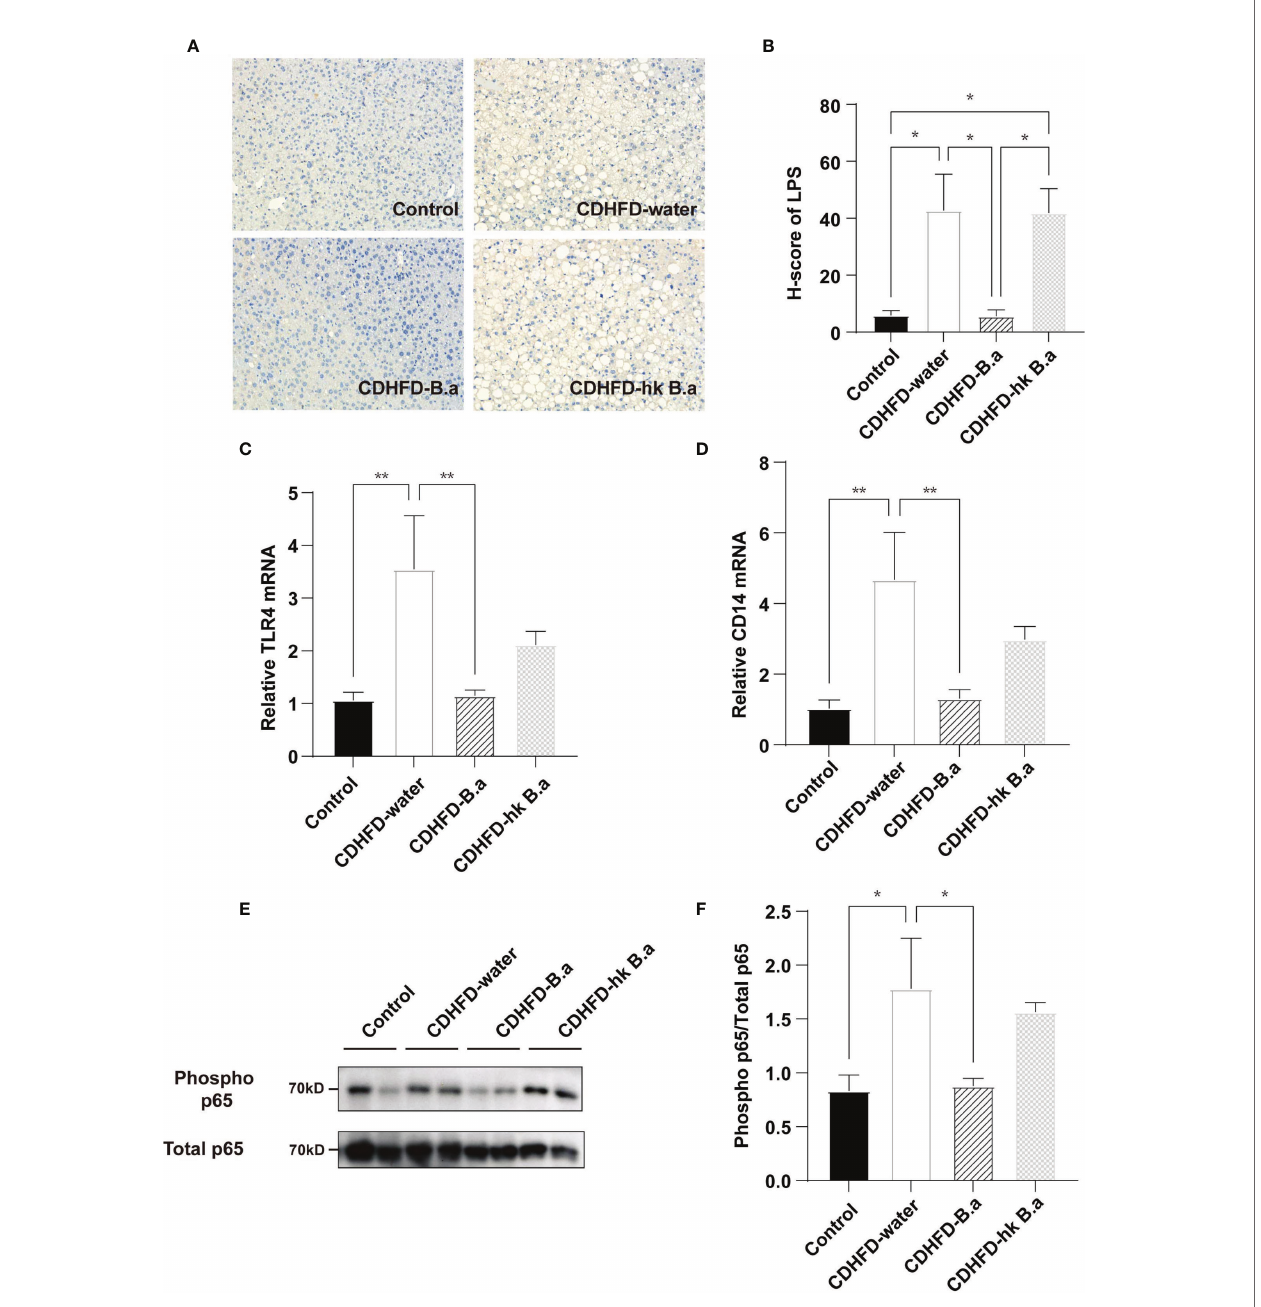
FIGURE 3 | Effects of B. adolescentis on TLR4 pathway. Mice were grouped and treated as in Figure 1 . (A) LPS location in liver detected by immunohistochemical staining. (B) H-score of LPS measured in ileum section with immuno fl uorescent staining. (C) The transcription of TLR4 in liver (n = 6 in each group). (D) The transcription of CD14 in liver (n = 6 in each group). (E) Phosphorylation of the p65 NF-kB subunit detected by western blot analysis. (F) Quanti fi cation of the relative phosphorylation of the p65 NF-kB subunit (n = 4). CD14, cluster of differentiation 14; H-score, histochemistry score; LPS, lipopolysaccharide; NF-kB, nuclear transcription factor-kappa B; TLR4, toll-like receptor 4. Data are presented as mean ± SEM. Signi fi cance was determined by one-way ANOVA with Fisher ’ s LSD multiple-comparison analysis. *p < 0.05; **p <